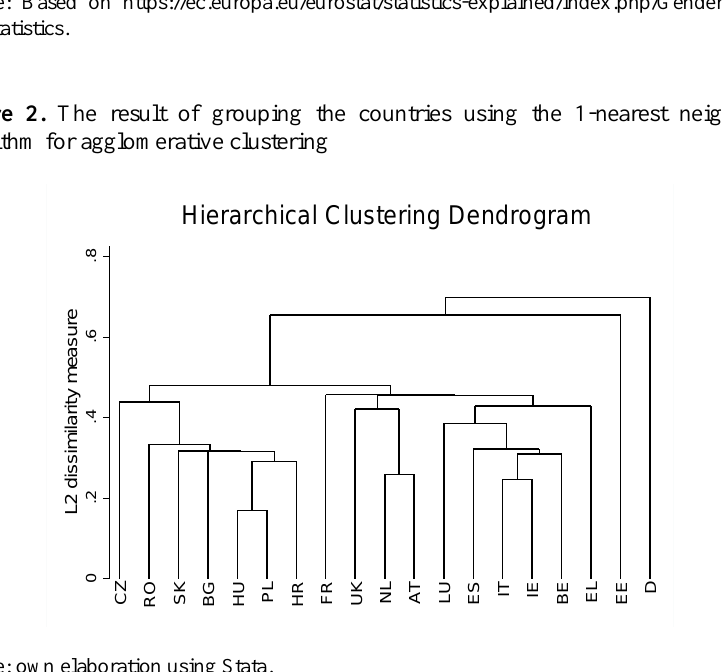
Source: own elaboration using